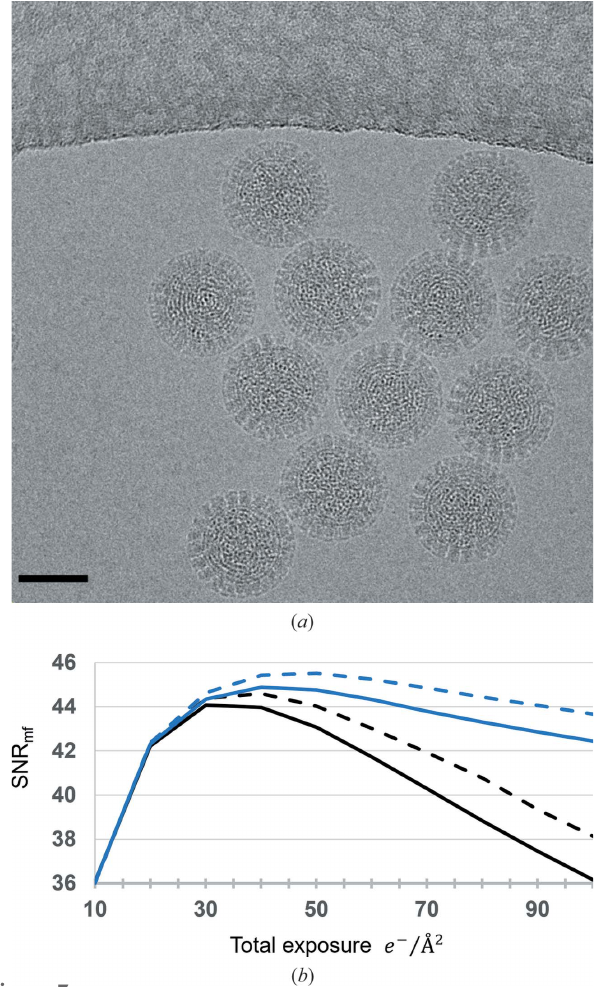
Figure 7 ( a ) Example image with a total exposure of (cid:4) 91 e (cid:2) A˚ (cid:2) 2 . Rotavirus DLPs from the data set used in this analysis, kindly shared by Dr Tim Grant. ( b ) Average SNR values as a function of total exposure. Solid black line: simple averaging of movie frames, no exposure filtering. Dashed black line: image summed from exposure weighted movie frames. Solid blue line: reference simulated with cumulative exposure filter as would normally be applied to a movie. Dashed blue line: both image and reference exposure filtered. Red square: maximum SNR attainable using a single B -factor to represent all envelopes. Scale bar 500 A˚